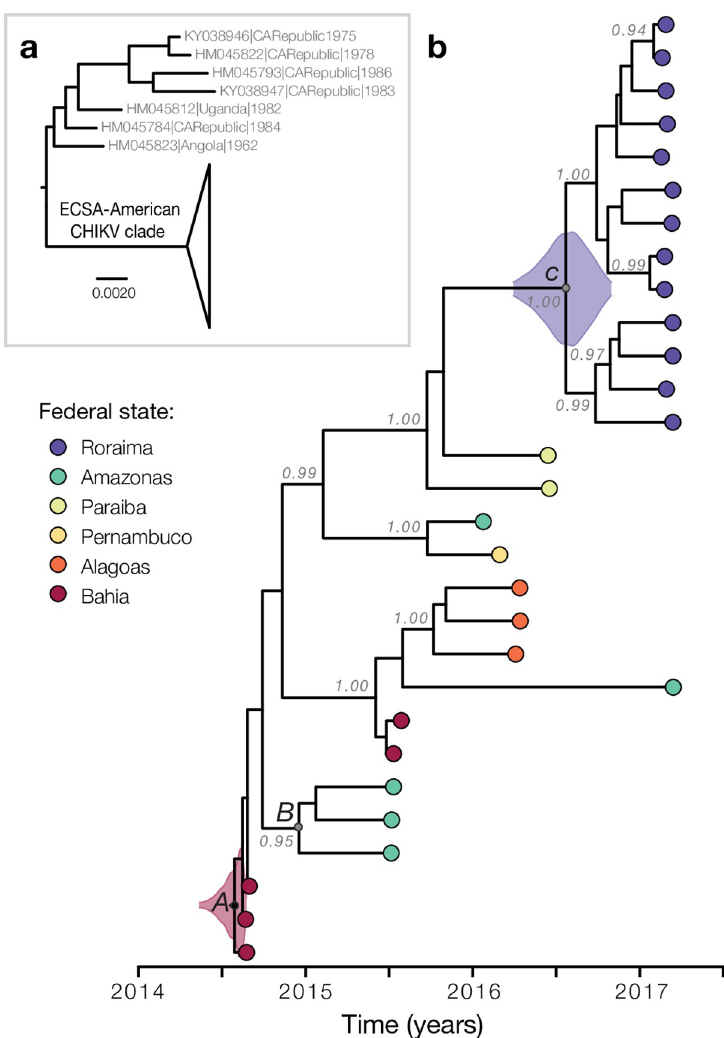
Fig 3. Genetic analysis of the CHIKV-ECSA genotype. A. Maximum likelihood phylogeny depicting the monophyletic clade containing all the Brazilian ECSA isolates (ECSA-Br lineage). B. Time-calibrated phylogeny of all available CHIKV-ECSA whole genome sequences from Brazil, including 18 novel genomes from Roraima and Amazonas states. Colours correspond to state of sample collection. Violin plots show 95% Bayesian credible intervals for associated node heights